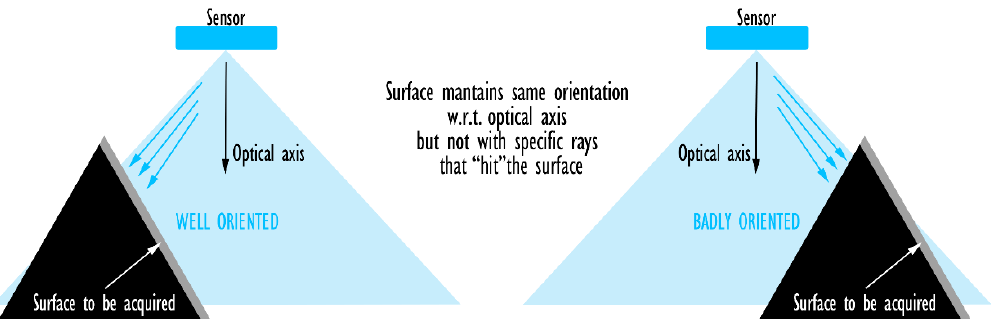
Figure 8. Modelling of the FOV of triangulation-based sensors. Effects of the relative position and orientation of a surface w.r.t. the sensor observing the scene. Use of optical axis vs actual optical rays.